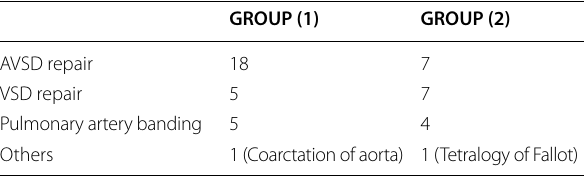
Table 3 Underline congenital heart disease in both groups of